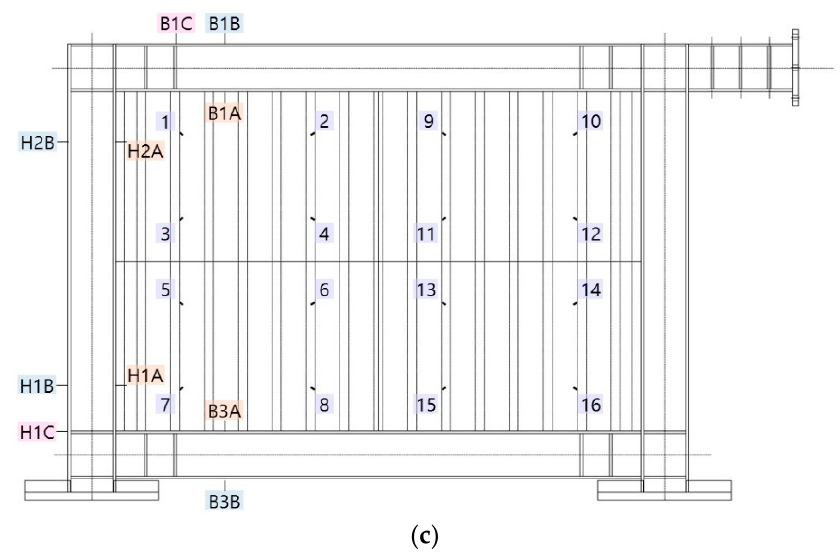
Figure 5. Location of strain gages: ( a ) FR-00; ( b ) FR-TR-V; ( c ) FR-TR-H.